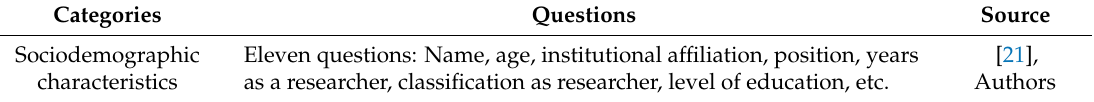
Table 2. Categories and questions for the first national survey on open science in